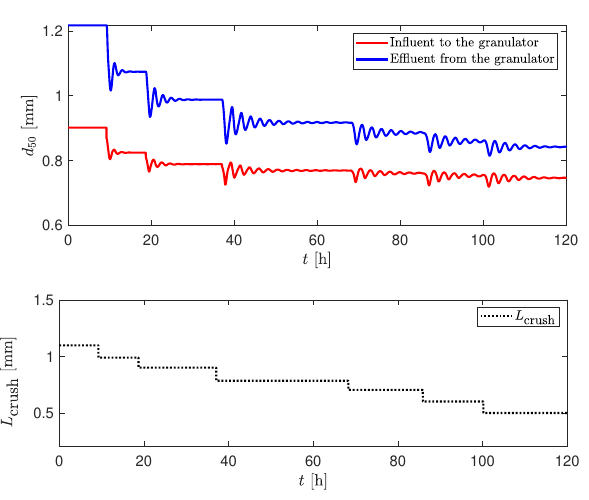
Figure 15: d 50 as a response to the step-by step change of L crush with ˙ m slurry = 1000